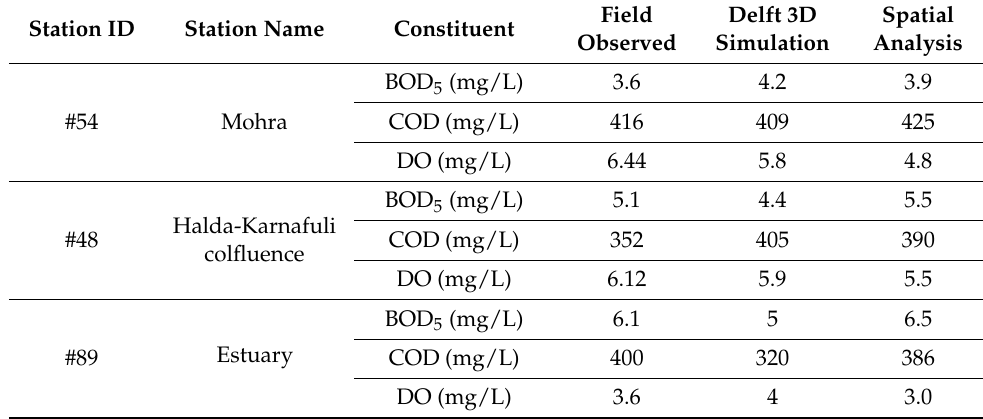
Table 1. Model prediction and observed values for different